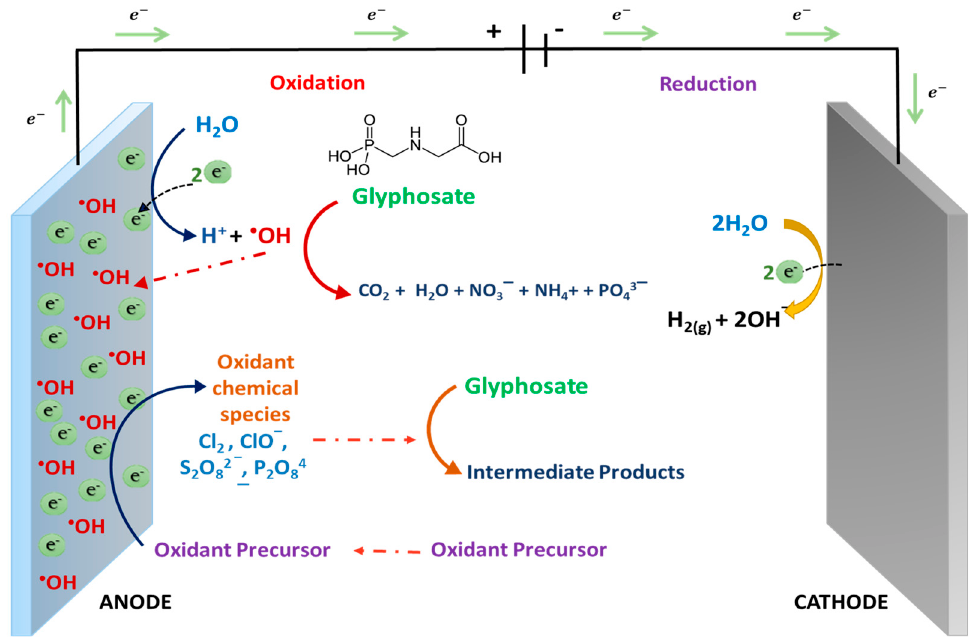
Figure 4. Oxidation mechanism of organic pollutants at non-active anodes.